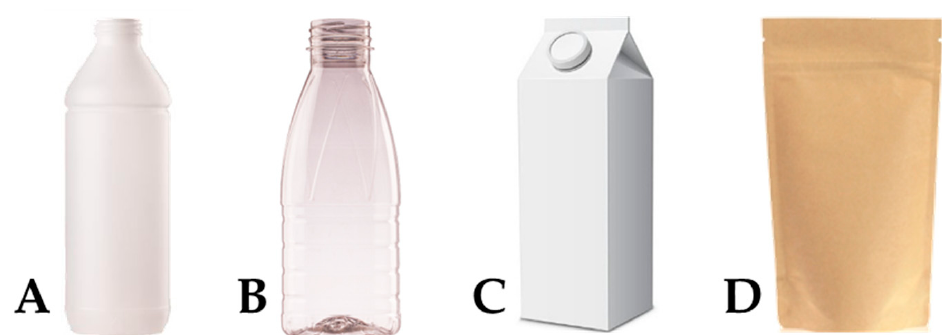
Figure 1. Packaging materials used for liquid whole egg product storage. ( A )—HDPE packaging made of high-density polyethylene. ( B )—PET packaging made of polyethylene terephthalate. ( C )—Tetra Rex ® Bio-based multi-layer packaging made of carton and low-density polyethylene (LDPE), and HDPE derived from sugar cane polymers. ( D )—Doypack multi-layer packaging made of carton and vinyl alcohol-co-ethylene (EVOH) layer.